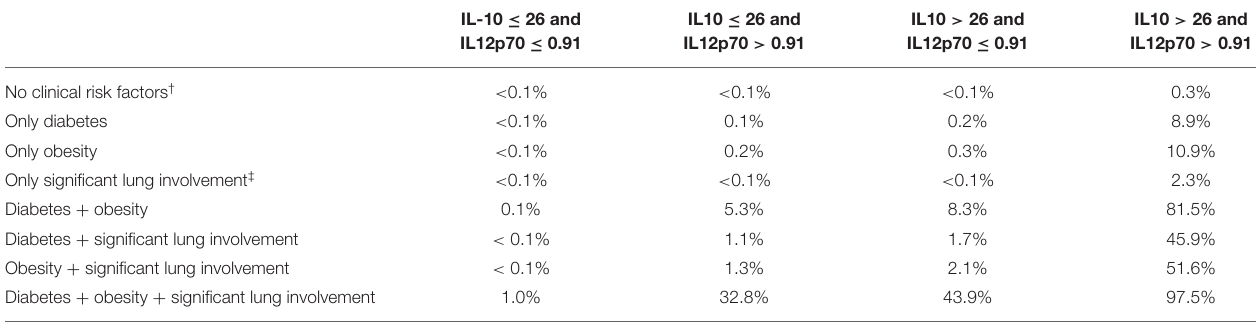
TABLE 5 | Probability of COVID-19 progression according to the final logistic